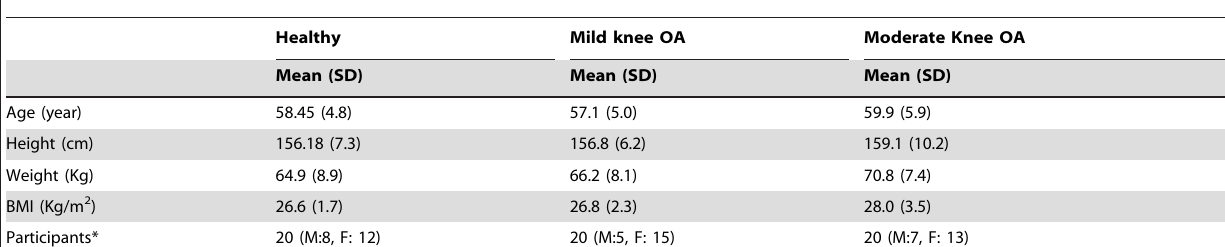
Table 1. Anthropometric information of all the participants.